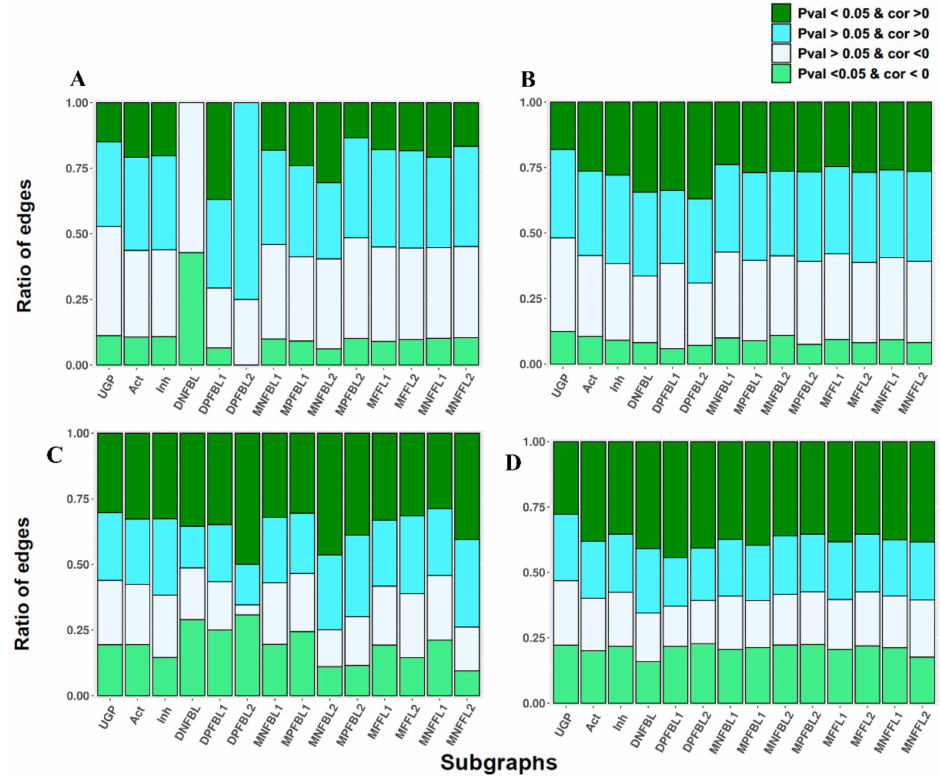
Figure 5. The ratio of eligible and homogeneous edges involved in di ff erent subgraphs are represented by stacker bar plots for all four analyses. ( A , B ) are KEGG / GEO and OmniPath / GEO plots, and ( C , D ) plots correspond to KEGG / GDSC and OmniPath / GDSC. Note that the unconnected gene pair (UGP) ratios are the average ratio over of all UGP sets. See Table 1 for the full names of